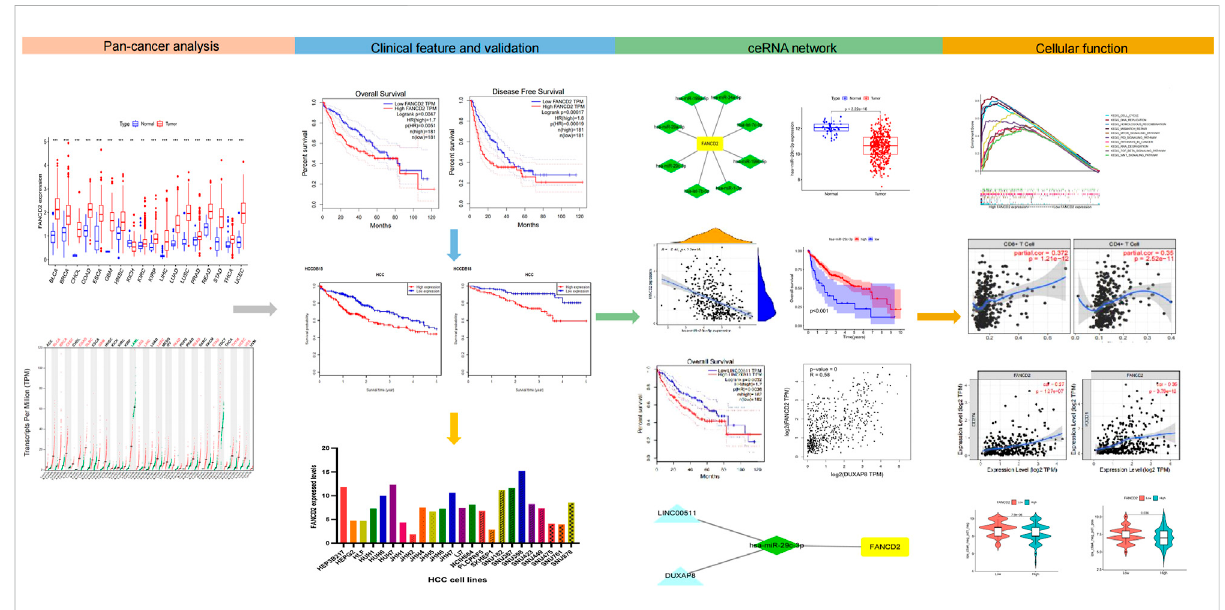
FIGURE 1 Research work fl ow of construction and analysis of the FANCD2 ceRNA